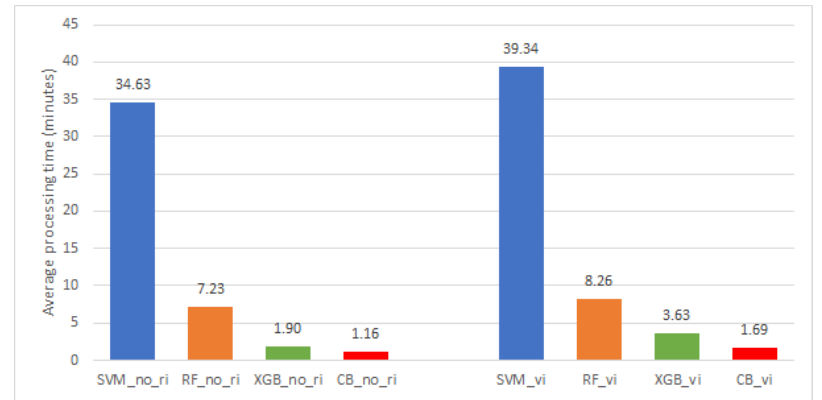
Figure 10. Average processing time for all twelve dates for SVM, RF, XGB and CB classification method with and without vegetation indices included.